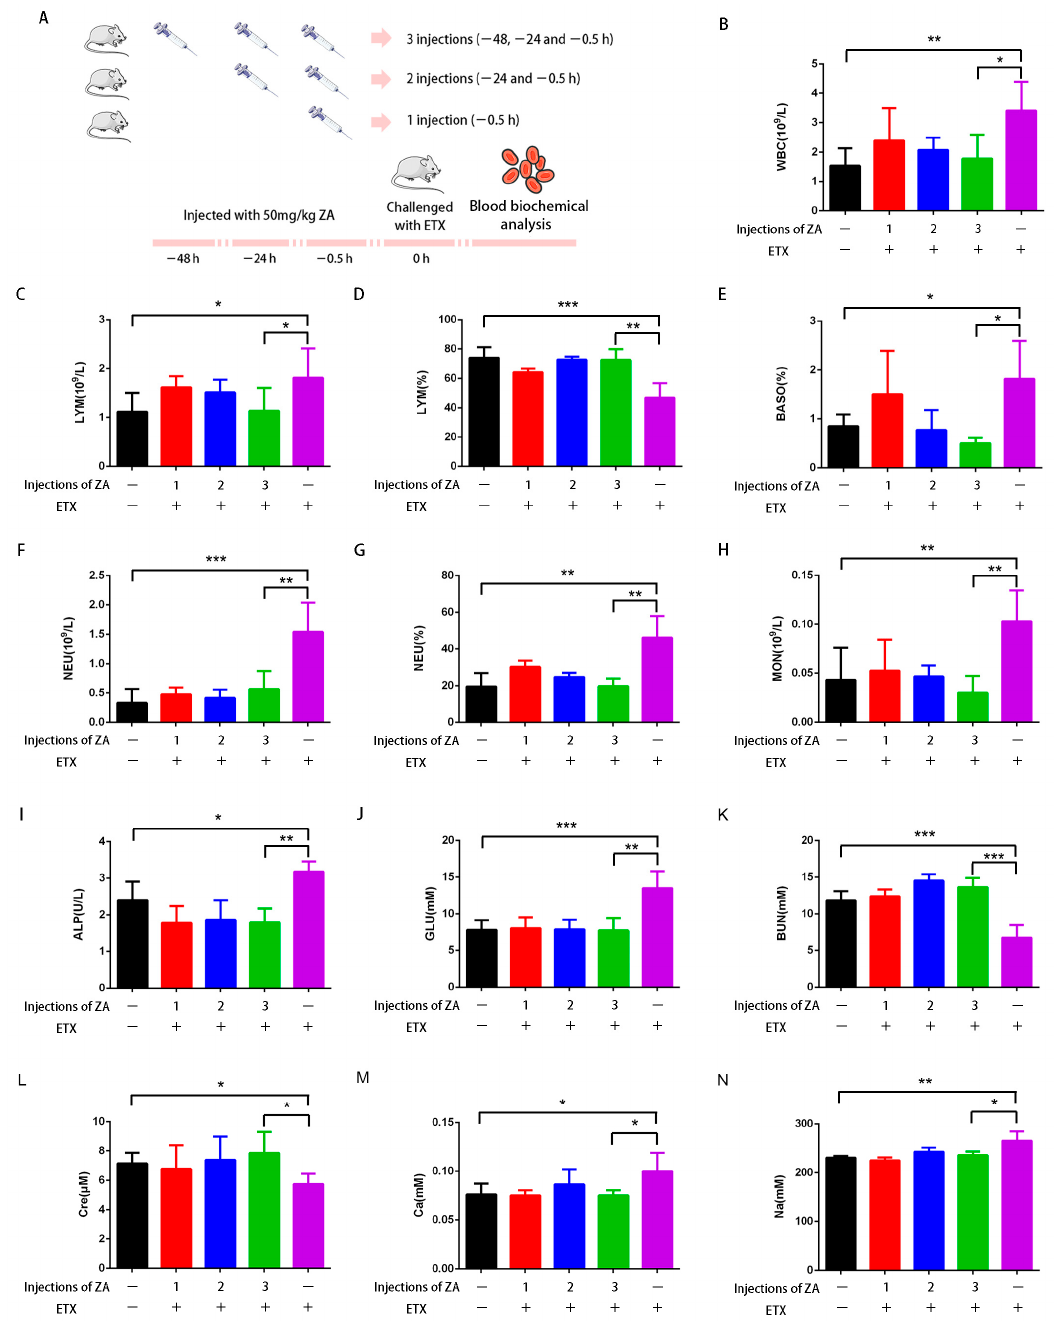
Figure 6. ZA can effectively protect mice from the toxicity of ETX. ( A ) Mice were injected with 50 mg/kg/day ZA for 3 injections ( − 48, − 24, and − 0.5 h), 2 injections ( − 24 and − 0.5 h) or 1 injection ( − 0.5 h) only, then challenged with 6400 ng/kg ETX at time 0. The blood of mice was collected, and blood parameters were examined. ( B ) White blood cells (WBC). ( C ) Number of lymphocytes (LYM). ( D ) Lymphocyte ratio (LYM%). ( E ) Basophils ratio (BASO%). ( F ) Number of neutrophils (NEU). ( G ) Neutrophil ratio (NEU%). ( H ) Number of monocytes (MON). ( I ) Alkaline phosphatase (ALP). ( J ) Glucose (GLU). ( K ) Urea nitrogen (BUN). ( L ) Creatinine (Cre). ( M ) Serum calcium (Ca). ( N ) Serum sodium (Na). * p <0.05, ** p <0.01 and *** p <0.001.